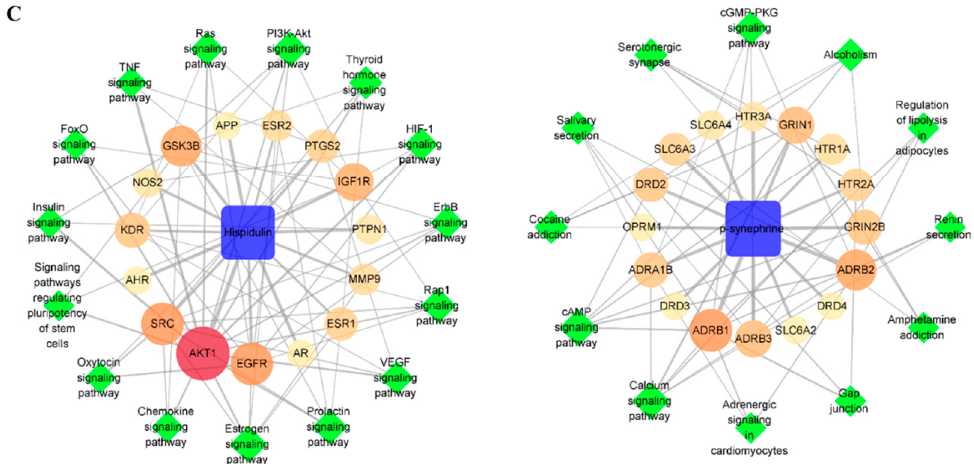
Figure 5. Integrated compound–target–pathway (C–T–P) networks. ( A ) C–T–P network of hispidulin. ( B ) C–T–P network of p -synephrine. ( C ) Combination C–T–P network of hispidulin and p - synephrine.